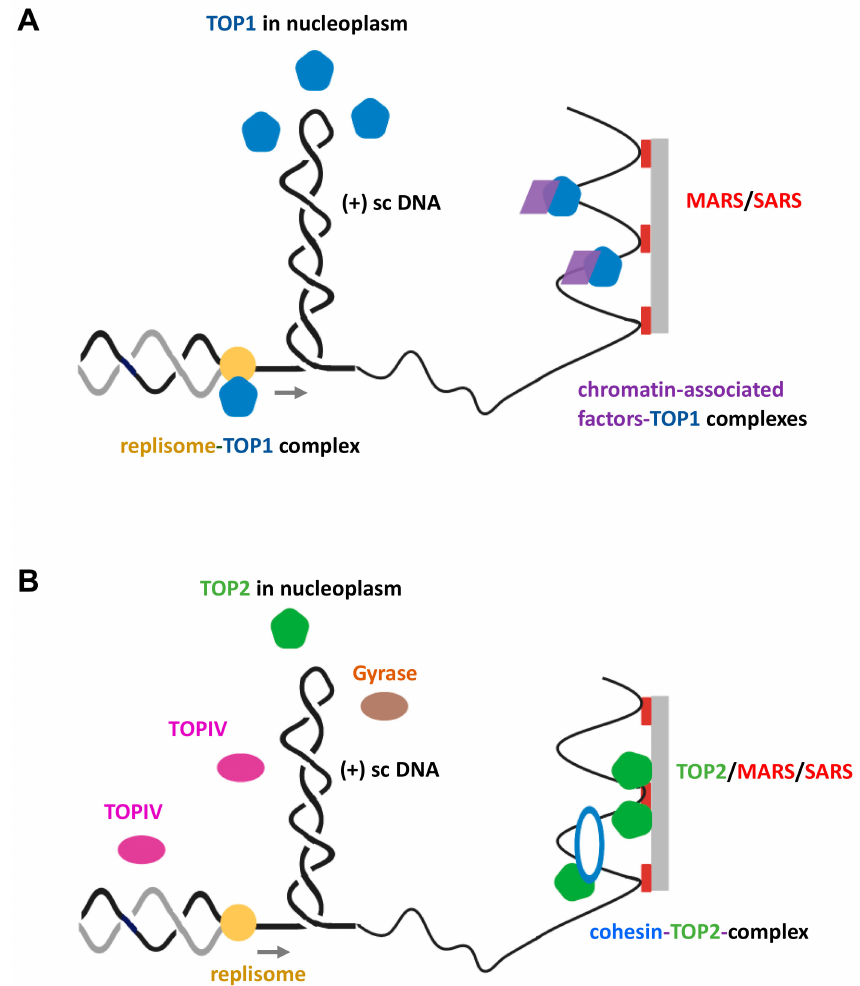
Figure 2. Various DNA topoisomerases function to maintain supercoil homeostasis at topologically stressed replication forks. ( A ) Topoisomerase type 1B (TOP1B) associates at regions of topological strain ahead of the replisome through diverse modes or travels in complex with the replisome, ultimately promoting DNA supercoil relaxation. ( B ) TOP2 enzymes preferentially relax ( + ) sc DNA ahead of the replication fork and can be physically associated with certain protein factors that are working as topological barriers throughout the genome. Note that TOPIV in prokaryotes is mainly responsible for the resolution of precatenanes behind the